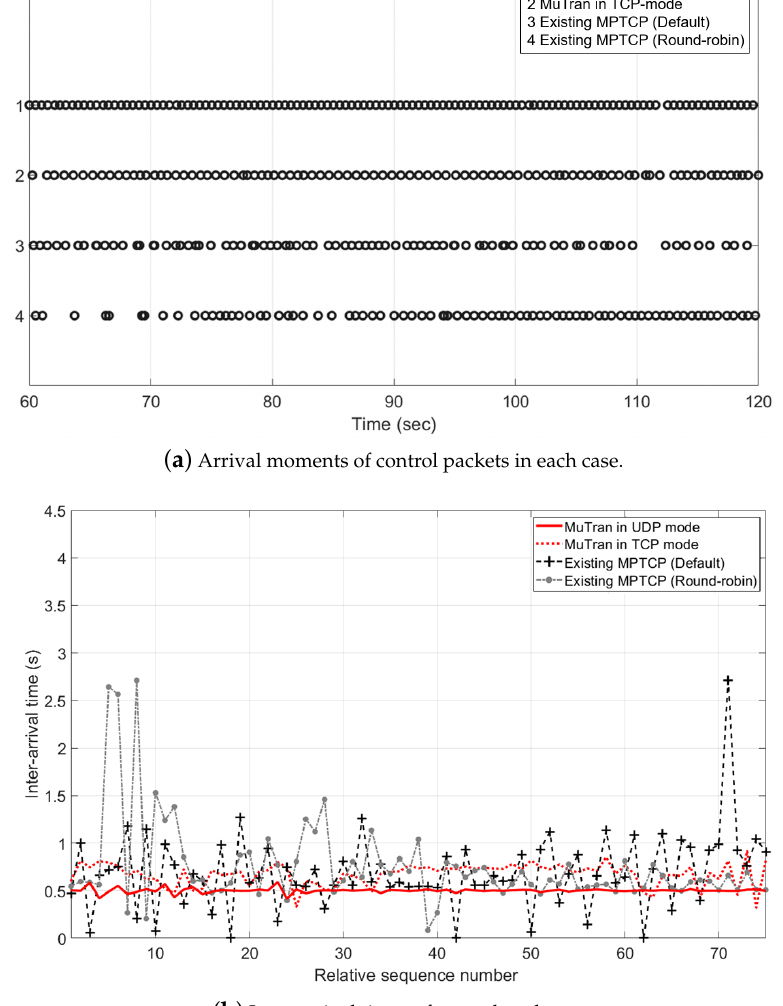
Figure 14. Performance comparison among MuTran and existing